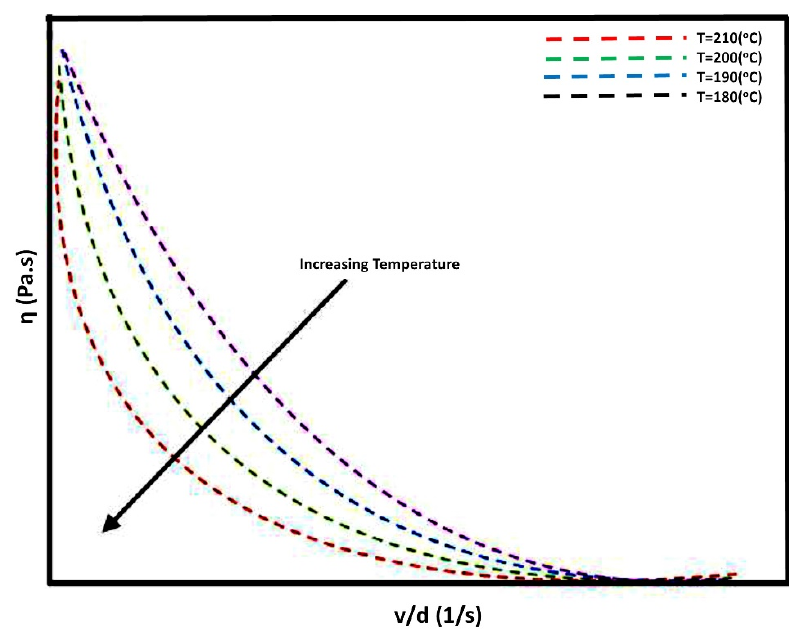
Figure 4. Correlation between printing speed/tube filament diameter and shear viscosity.